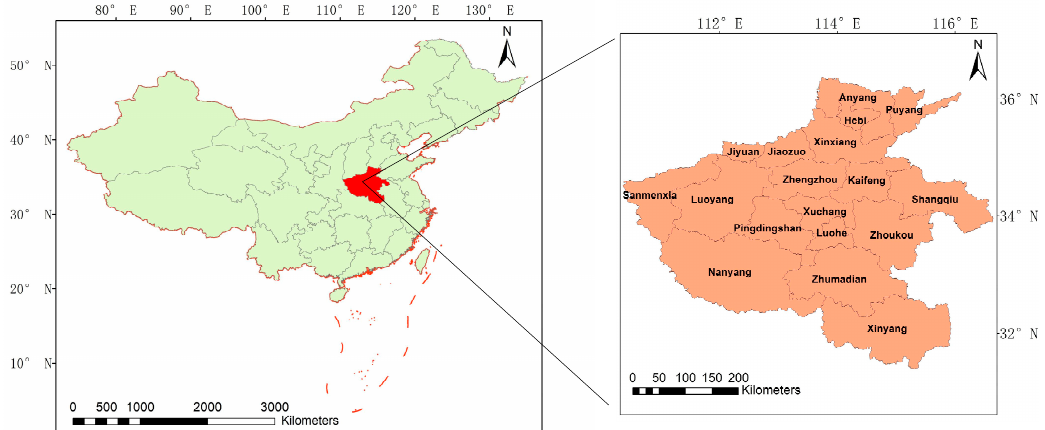
Figure 1. The area of study .